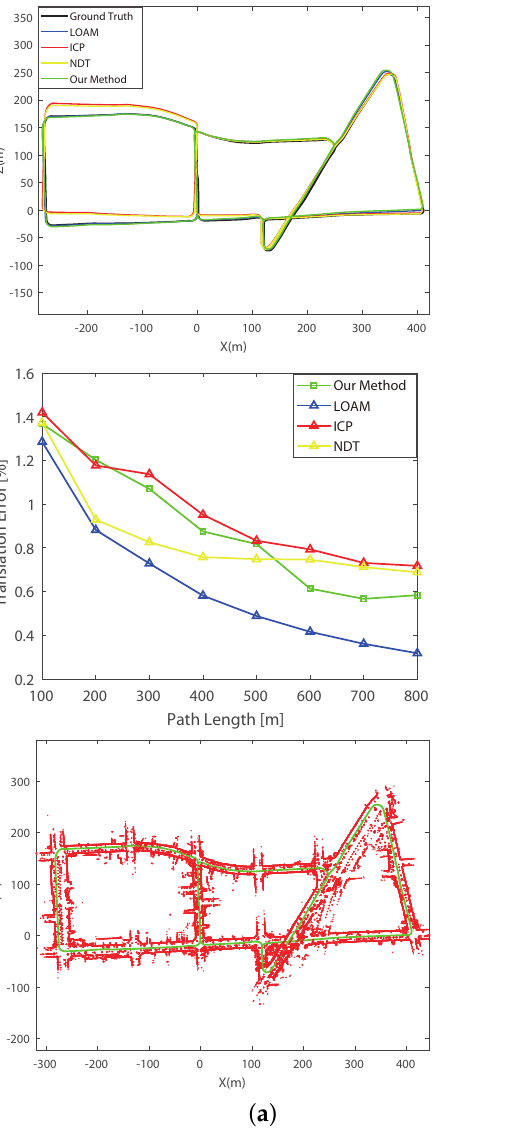
Figure 16. Paths and mapping results from the KITTI datasets. ( a ) Scequence 13. ( b ) Scequence